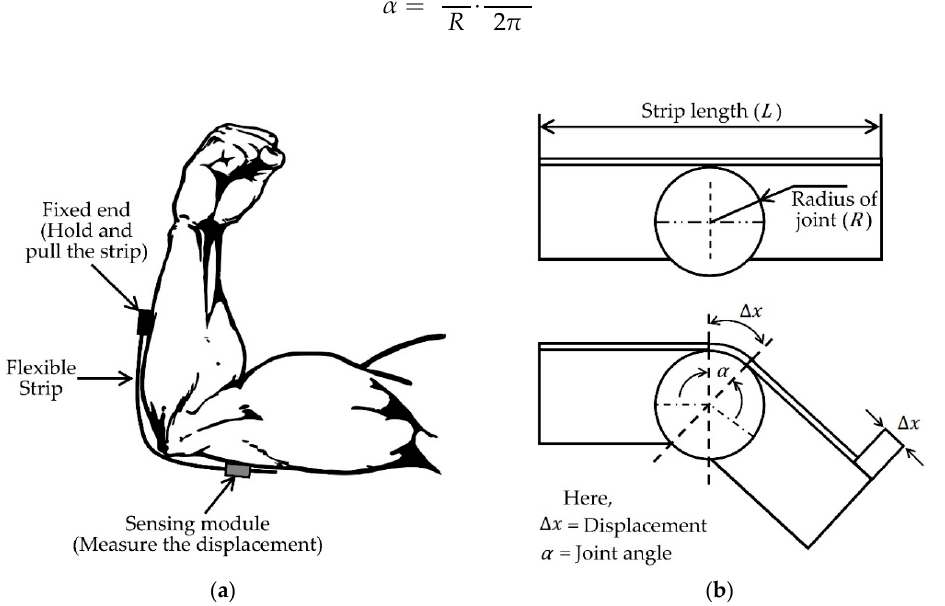
Figure 7. ( a ) Sensing setup of optical-based goniometer system for human elbow joint measurement; ( b ) operation method of the system.